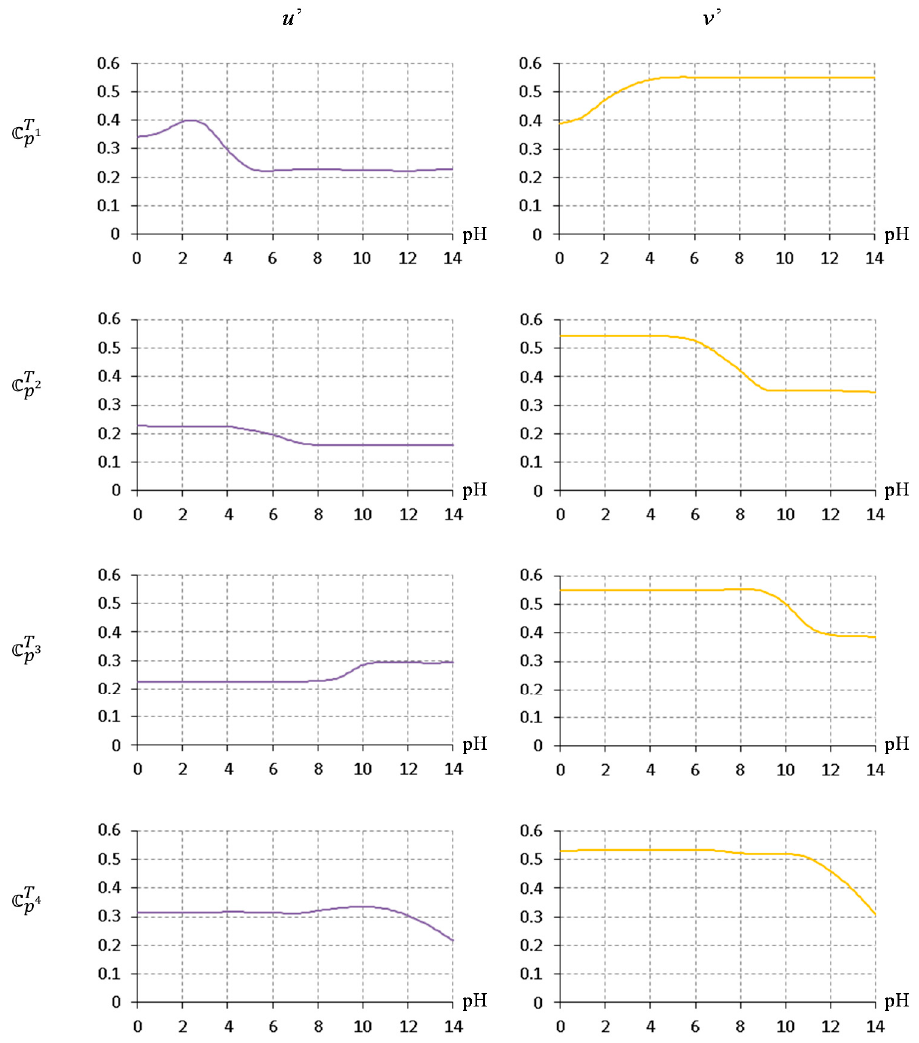
Figure 8. CIE 1976 u’ v’ color component of the high-resolution calibrated target colors C T k p